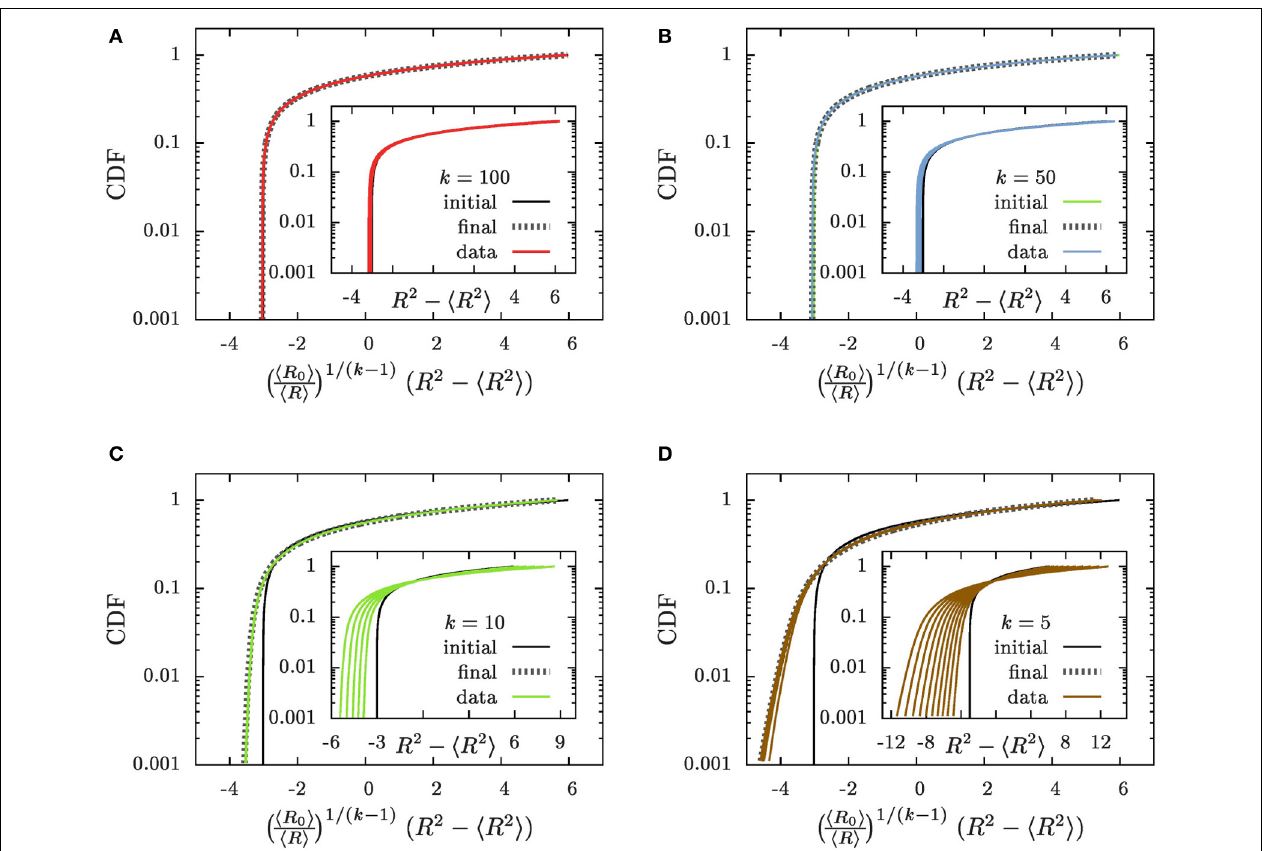
FIGURE 7 | The CDFs (A) k = 100, (B) k = 50, (C) k = 10, and (D) k = 5. The insets show the CDFs as a function of x = R 2 − Equations (22, 23), and the main panels the dependence on ˜ x which has been defined in Equation (30). The initial conditions are provided by solid black lines labeled by the tag “initial,” and thin lines with colors matching